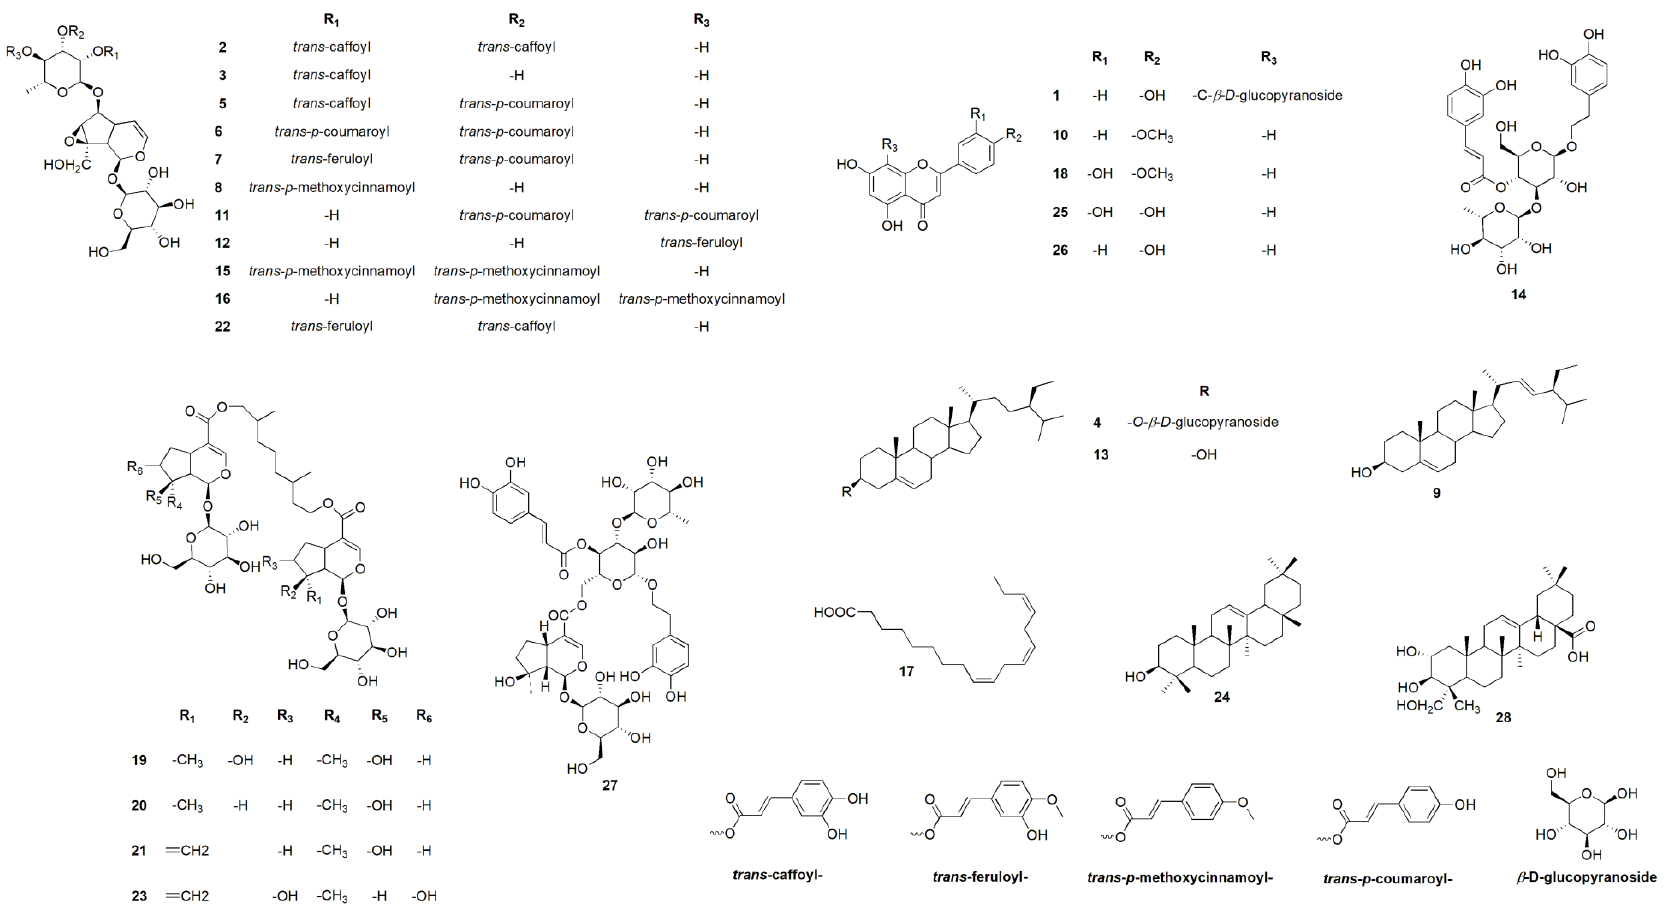
Figure 1. Dereplicated metabolites from the LC–HRESIMS analysis of the crude Premna odorata leave extract and fractions.